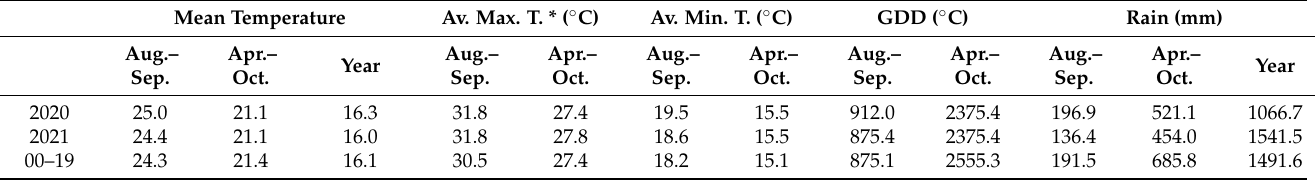
Table 2. Basic climatic conditions at the Mostar locality during 2020–2021 and average data for the period